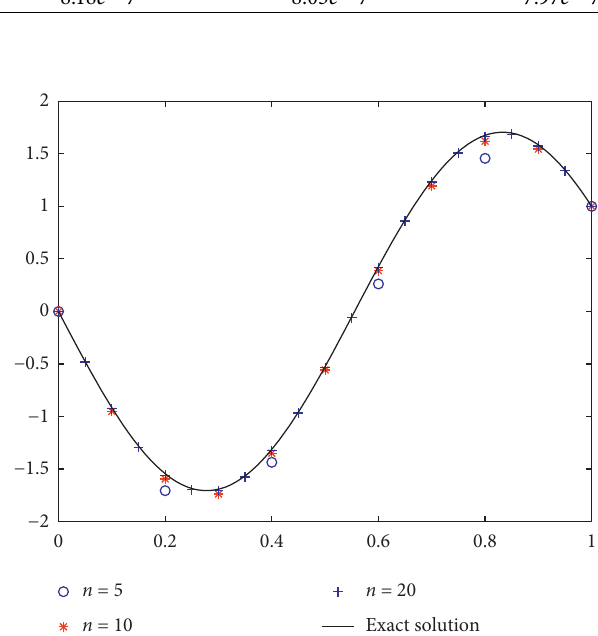
Figure 4: Results of the boundary value problem (76) for ε � 1/32, and n � 5 , 10, and 20,